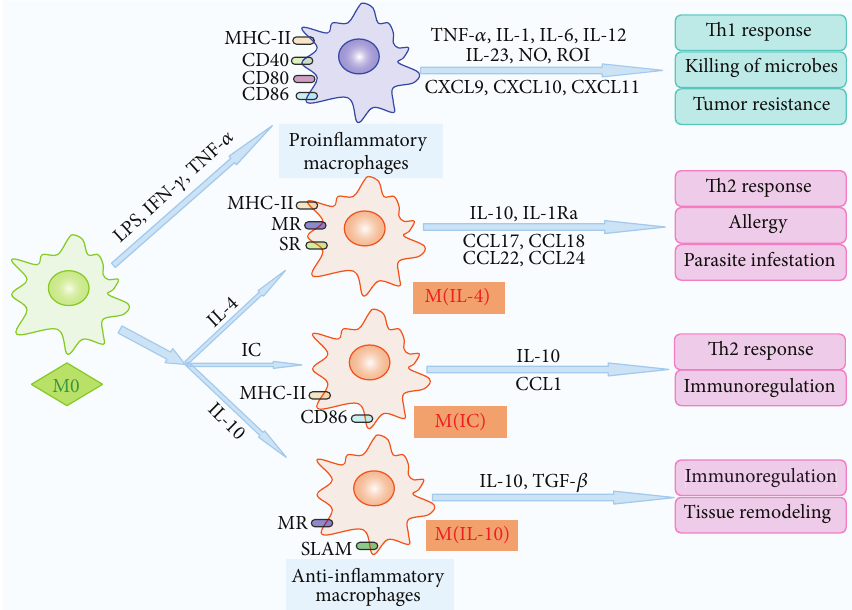
Figure 2: Macrophage polarization into proinflammatory and anti-inflammatory macrophages. Macrophages polarize and acquire different functional properties in response to numerous factors from the microenvironment. Macrophages activated by IFN- 𝛾 , LPS, or TNF- 𝛼 can develop proinflammatory macrophages, with strong microbicidal and tumoricidal properties. In contrast, anti-inflammatory macrophages contribute to Th2 response, immunoregulation, and tissue remodeling. Anti-inflammatory macrophages have different subsets. M(IL-4) macrophages (induced by exposure to IL-4) secret TNF- 𝛼 , IL-1, and IL-6 and induce Th2 cell response and allergy. M(IC) macrophages (induced by IC) secret IL-10 and exert immunoregulatory function. M(IL-10) macrophages (induced by IL-10) secret IL-10 and TGF- 𝛽 , suppress immune responses, and promote tissue remodeling. CCL, CC-chemokine ligand; CXCL, CXC-chemokine ligand; IC, immune complexes; IFN- 𝛾 , interferon 𝛾 ; LPS, lipopolysaccharide; MHC-II, major histocompatibility complex-II; MR, mannose receptor; NO, nitric oxide; ROI, reactive oxygen intermediates; SLAM, signaling lymphocytic activation molecule; SR, scavenger receptor; TGF- 𝛽 , transforming growth factor- 𝛽 ; TLR, toll-like receptor; TNF- 𝛼 , tumor necrosis receptor- 𝛼